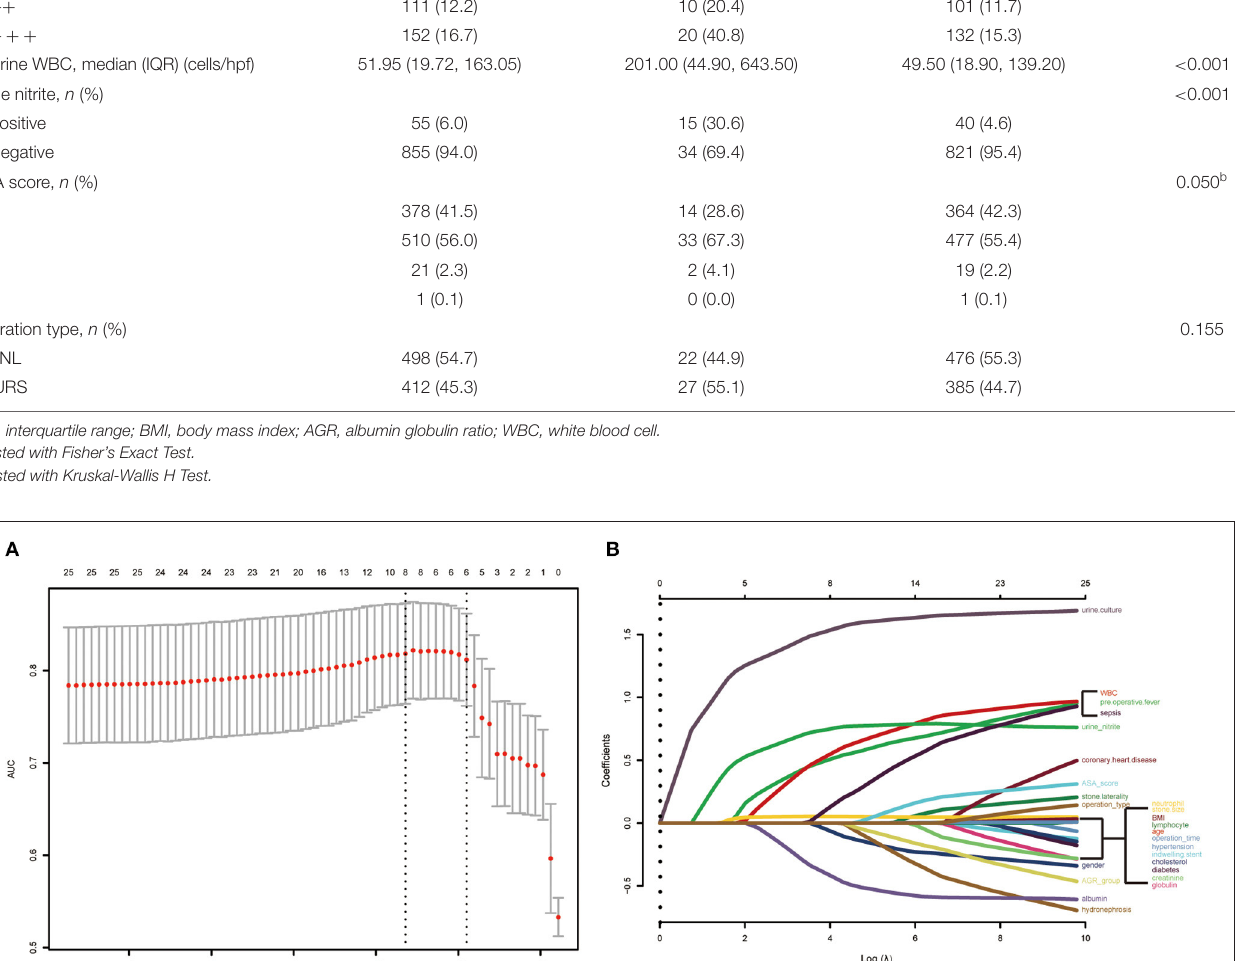
independent risk factor of sepsis after PNL and fURS respectively (9, 29). Therefore, it is reasonable that hypoalbuminemia is also a latent predictor for post-operative sepsis in our